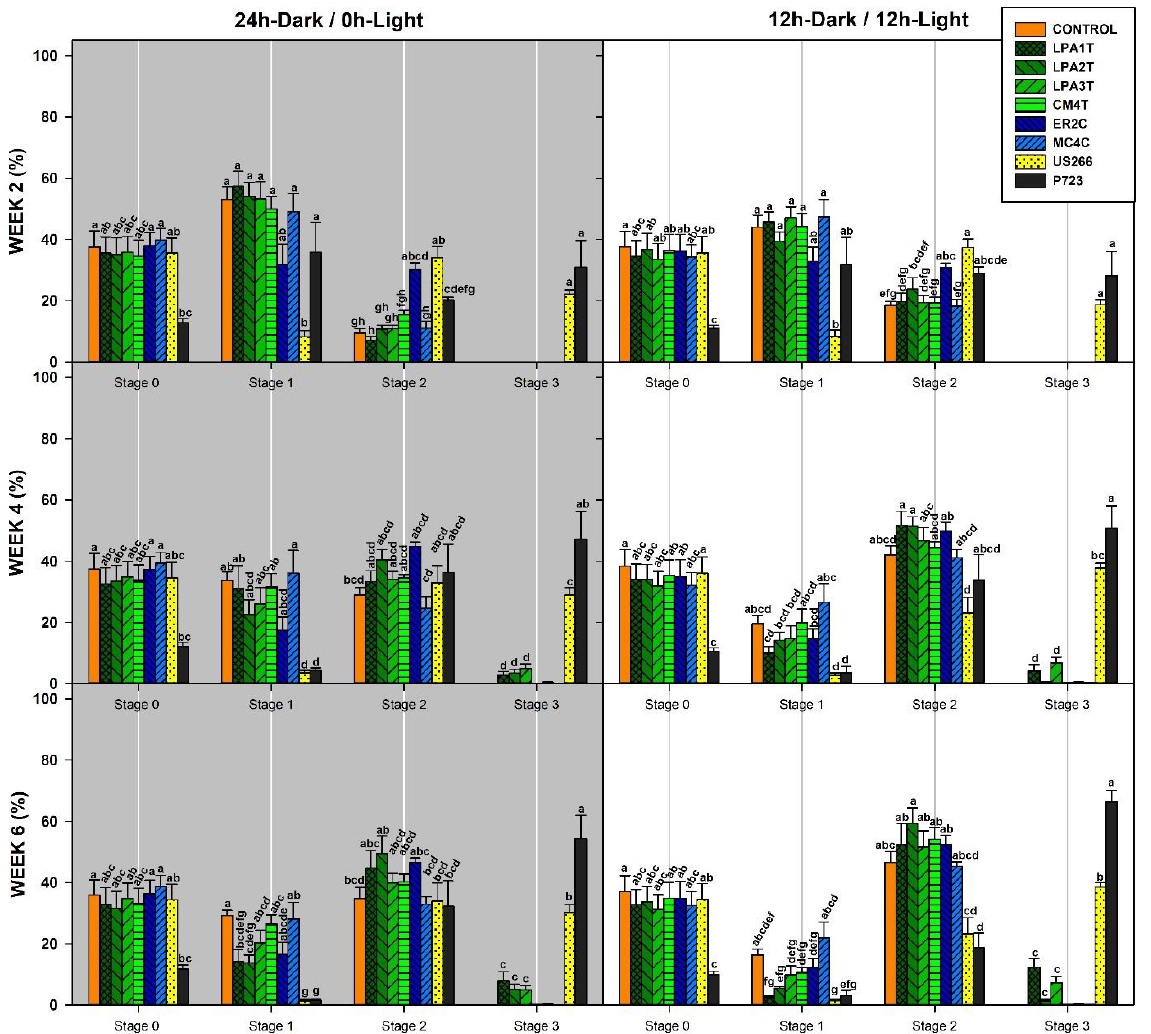
Figure 7. Comparative effects of photoperiod and symbiotic treatments on seed germination and early seedling development stages of Epidendrum geminiflorum incubated at 20 °C for 2, 4, and 6 wks. Shaded areas indicate 24 h-Dark/0 h-Light photoperiod Histobars with the same letter are not significantly different ( α = 0.05).